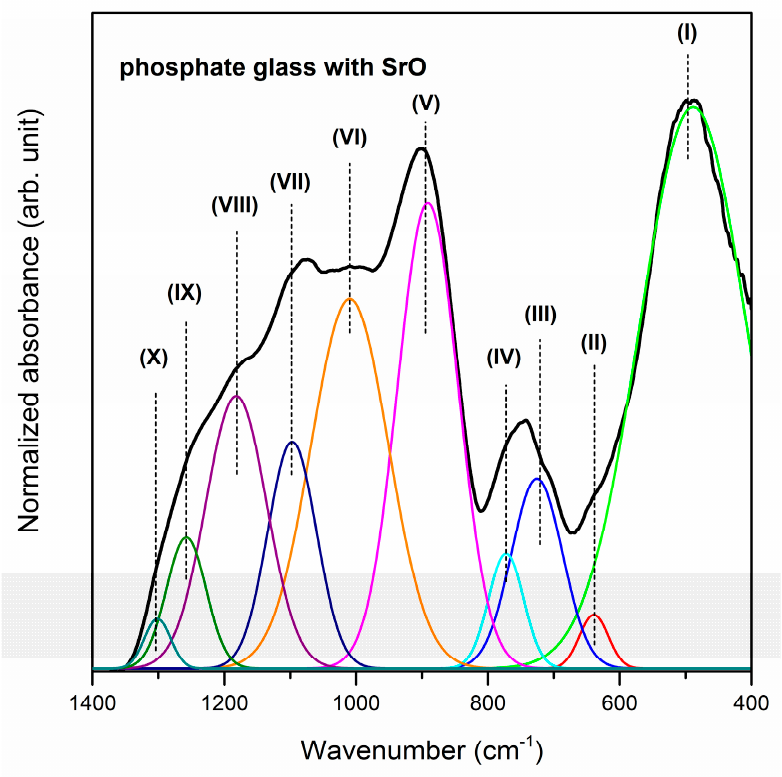
Figure 2. Deconvoluted near-infrared spectra of phosphate glass with SrO as oxide glass modifier.